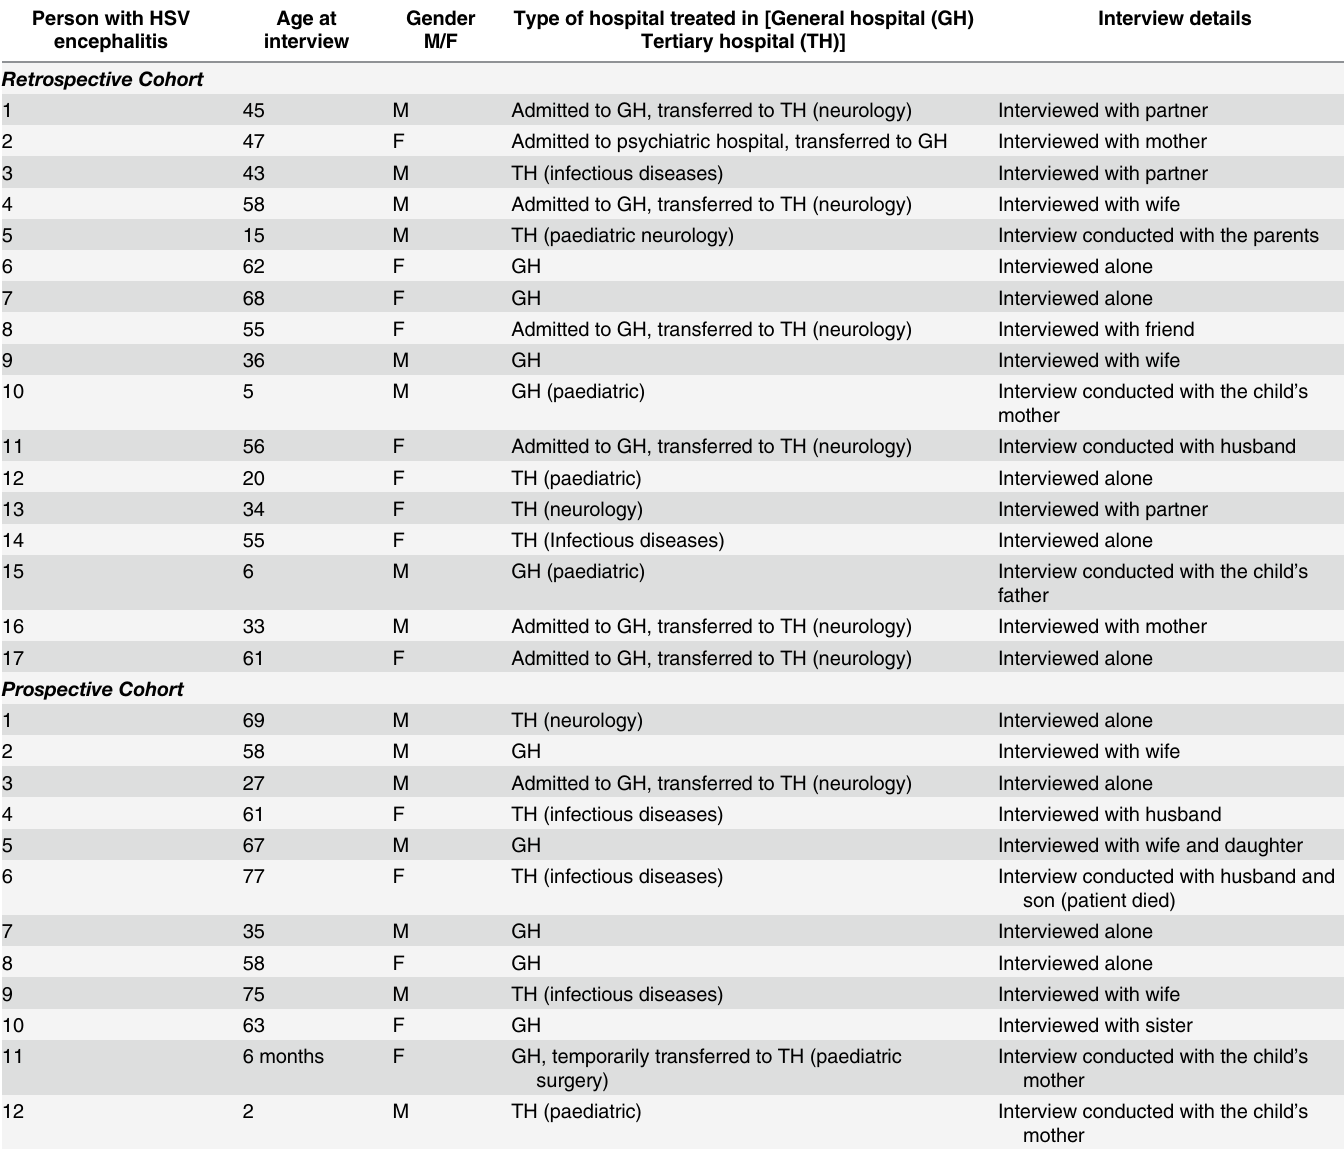
Table 1. Participant characteristics and interview details of patients with HSV